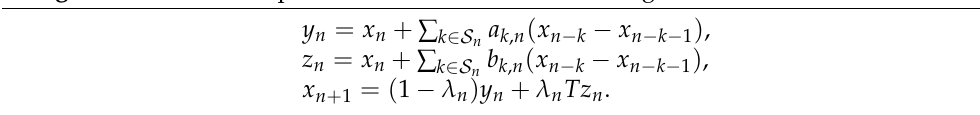
Algorithm 5: Multi-step inertial Krasnosel’skiˇı–Mann